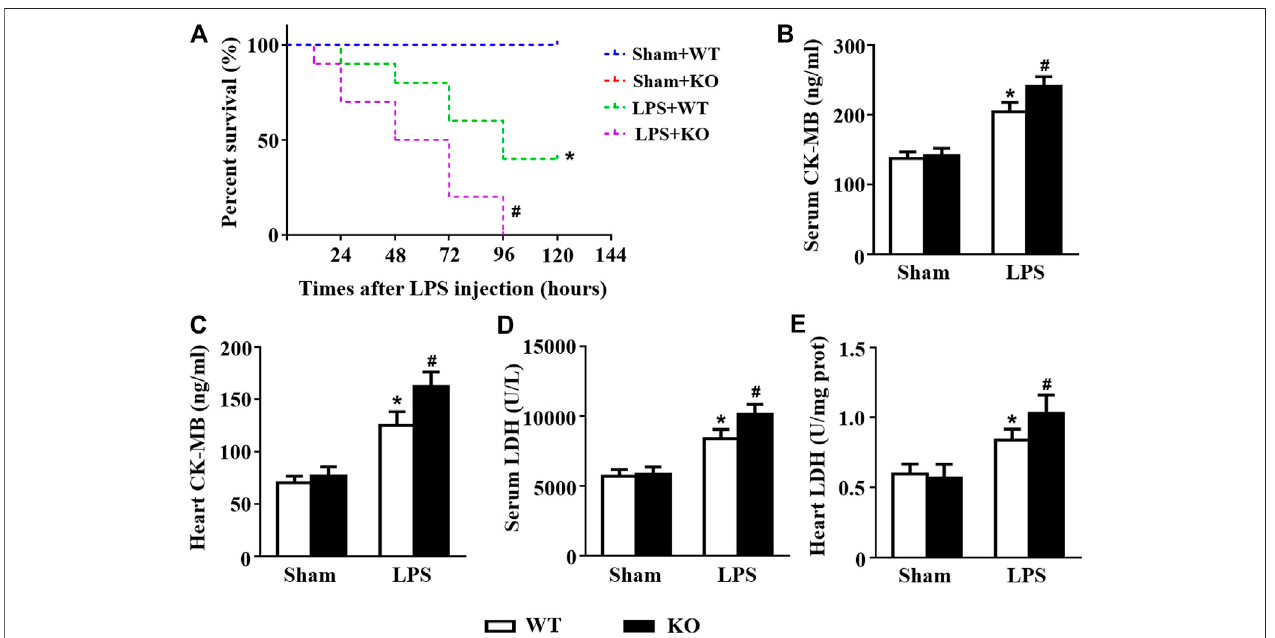
FIGURE 2 | Il12a deletion aggravates LPS-induced cardiac injury. (A) Effect of Il12a de fi ciency on the survival rate after LPS treatment (n (cid:1) 10). (B,C) CK-MB and LDH serum levels were assessed in each group (n (cid:1) 4). (D,E) The cardiac levels of CK-MB and LDH were measured in each group (n (cid:1) 4). * p < 0.05 compared with the sham + WT group; # p < 0.05 compared with the LPS + WT group.